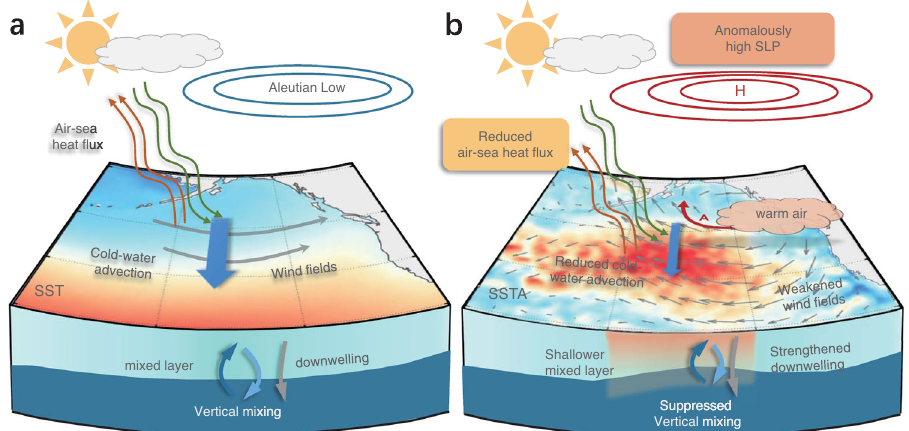
Fig. 8 Schematic fi gure of the Blob formation. Schematic dynamic processes of ( a ) the SST variations in winter (October – January) in the climatological state and ( b ) the Blob ’ s formation in the winter of